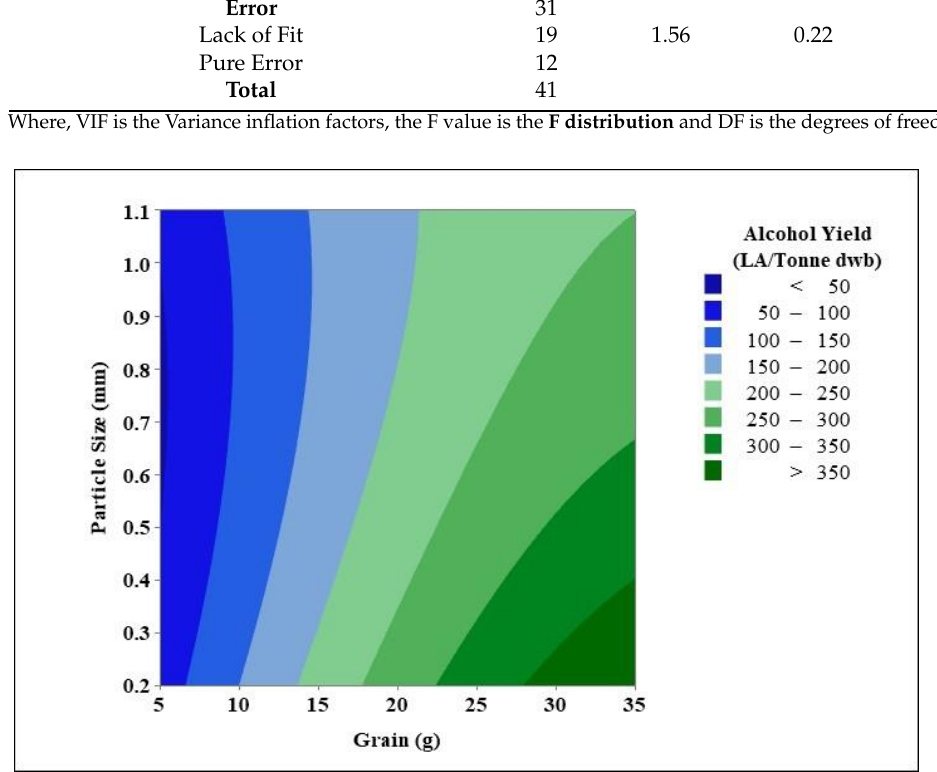
Figure 2. Contour plots showing the mean alcohol yields achieved during the response surface model, using varying grain amounts and grain particle sizes.